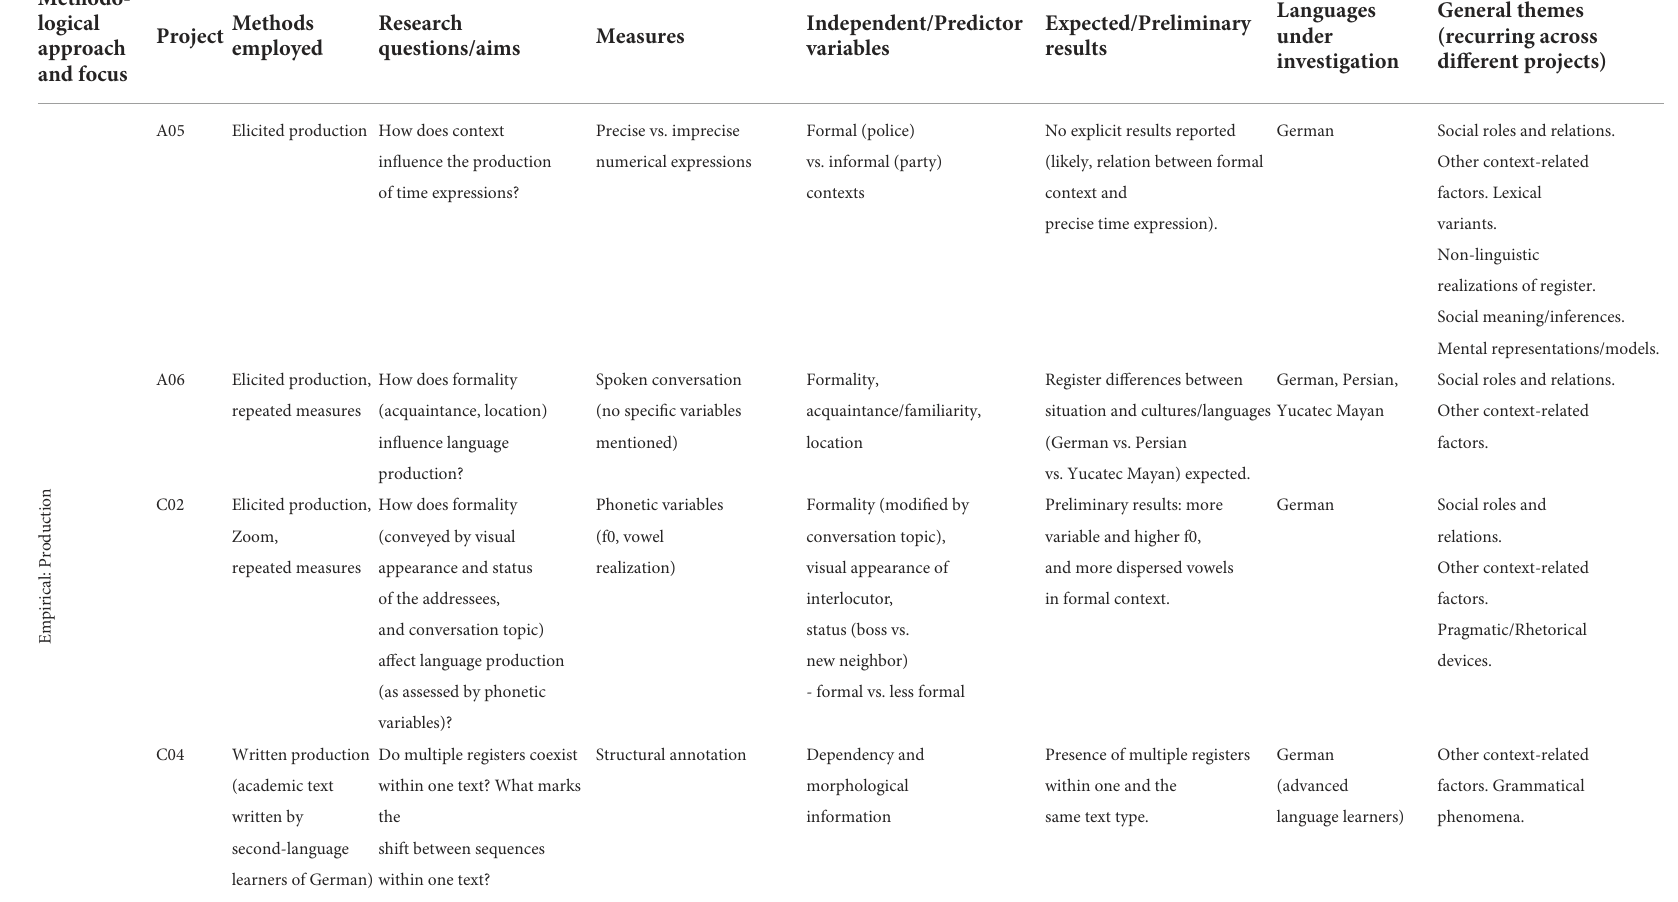
TABLE 1 Overview of the projects, their methods, languages, and results in the CRC 1412